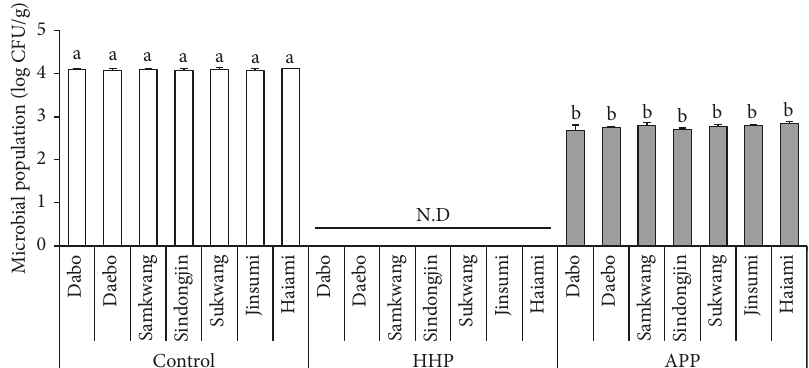
Figure 1: Microbial population (log CFU/g) of rice. Samples were treated by high hydrostatic pressure or atmospheric pressure plasma, and microbial populations were compared to control. Values with different superscripts are significantly different at p Tukey’s multiple range tests within the same cultivar. ND, not (0 log CFU/g) and was more effective for microbial regu- lation than APP.